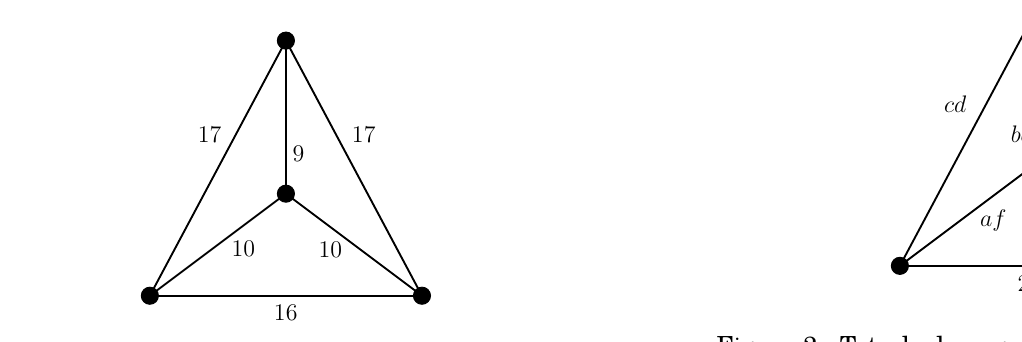
Figure 1: Tetrahedron graph with smallest diameter.